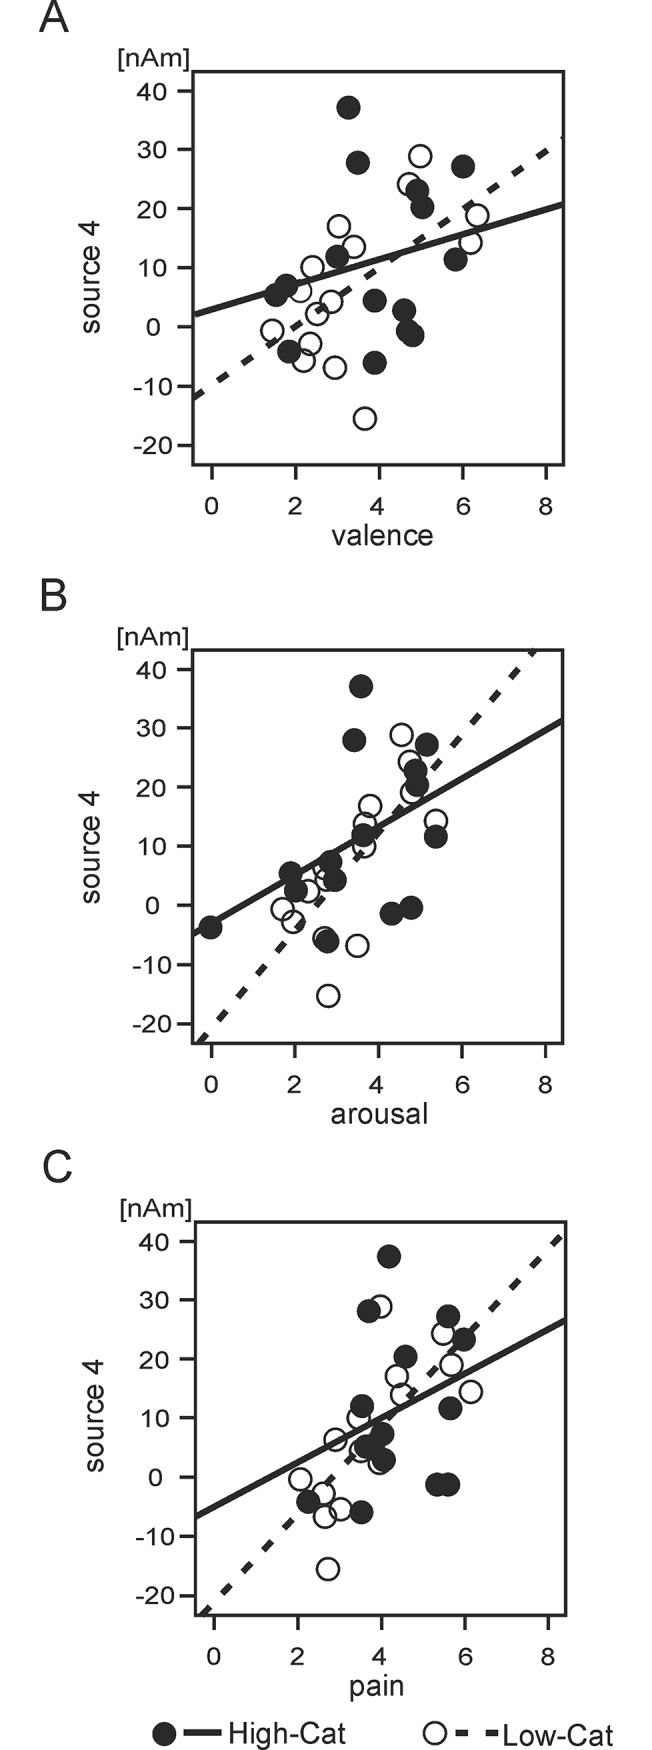
Correlations between source components and picture ratings.Scatter plots and the linear regression lines illustrating relationships between subjective ratings of valence, arousal and pain attributed to visual stimuli and the source amplitude differences between two conditions in the posterior cingulate source dipole in the interval of from 756 to 1144 ms. A. Valence. B. Arousal. C. Pain. High-Cat = high pain catastrophisers, dark circles, solid line. Low-Cat = low pain catastrophisers, white circles, dashed line.